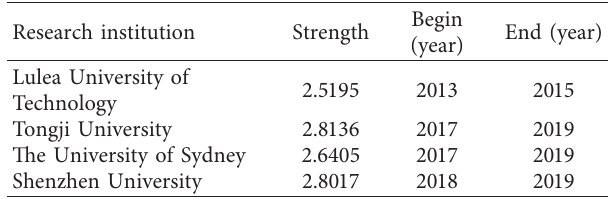
Figure 3: Network of countries/regions and institutions. Table 3: Top four research institutions with the strongest citation